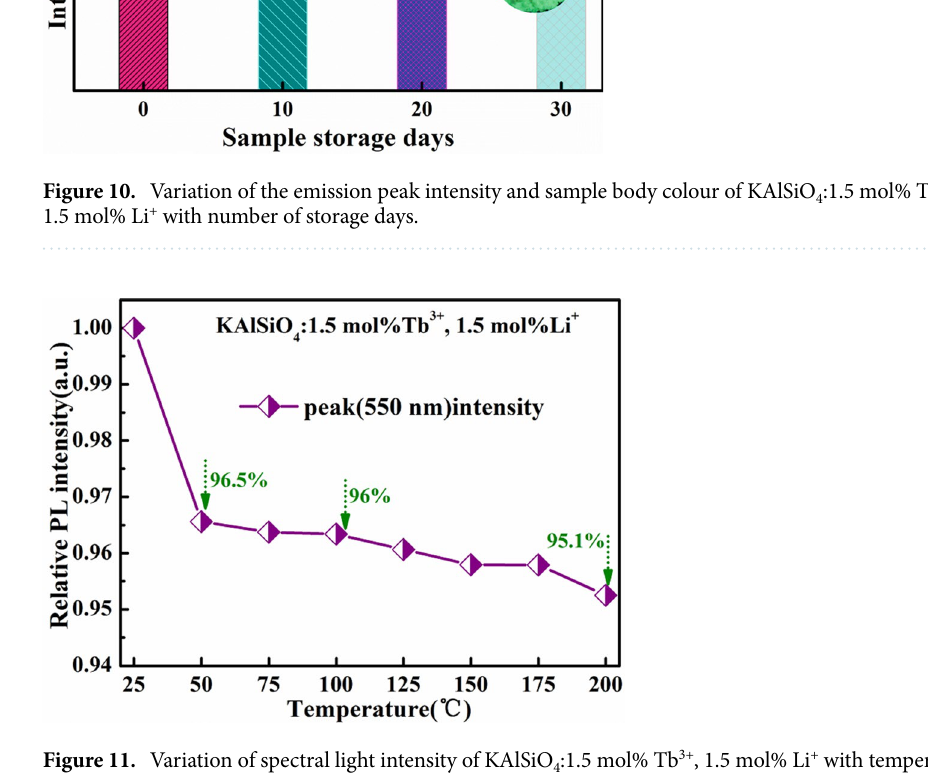
luminous efficiency and good thermal stability. This shows that the luminescence performance of the silicate phosphor has room for improvement. It is expected to be suitable for green phosphors in LED devices for a new generation of solid-state lighting.